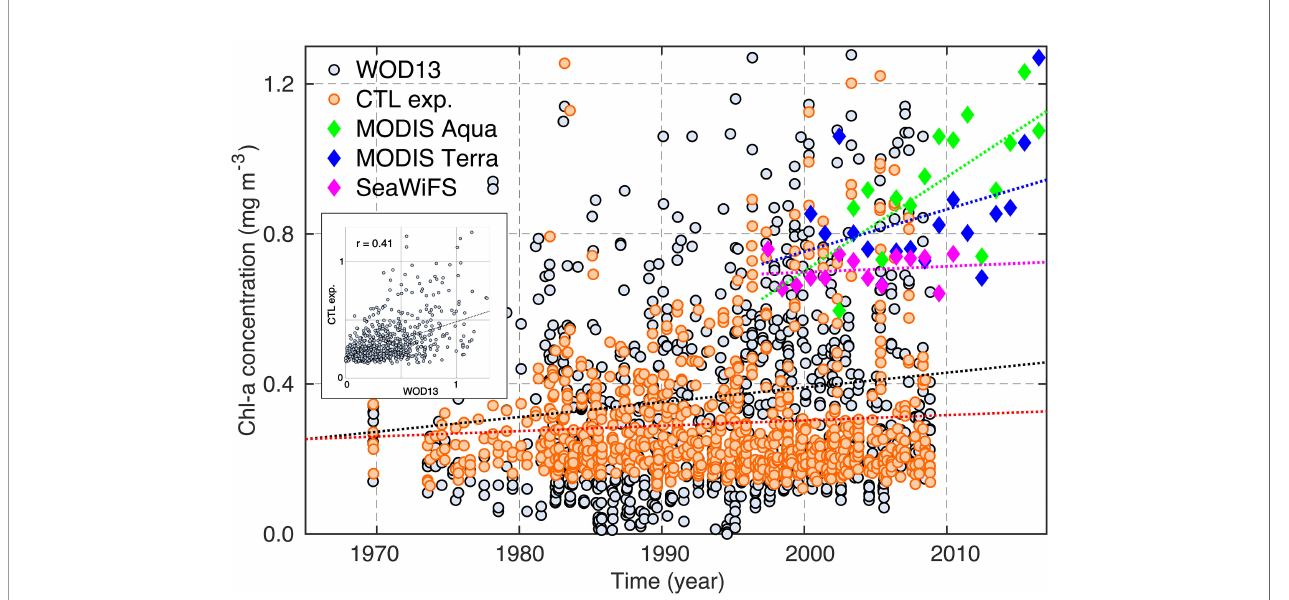
FIGURE 2 | Time series of the surface chlorophyll-a (Chl-a) concentration. The orange circles indicate simulated Chl-a concentration values (the control experiment: CTL exp.), which were selected to correspond to the closest location and date relative to the in situ observation data (World Ocean Database 2013: WOD13). The gray circles and green, blue, and magenta squares show the in situ and satellite measurement data, respectively. The satellite data are represented by annual mean values. The dotted lines denote the linear regression lines of each dataset. The long-term tendencies of the Moderate Resolution Imaging Spectroradiometer (MODIS) Aqua, WOD13 and model data are statistically signi fi cant at the 95% con fi dence level ( p < 0.05). The inset scatter plot compares the Chl-a concentration between the WOD13 and the CTL